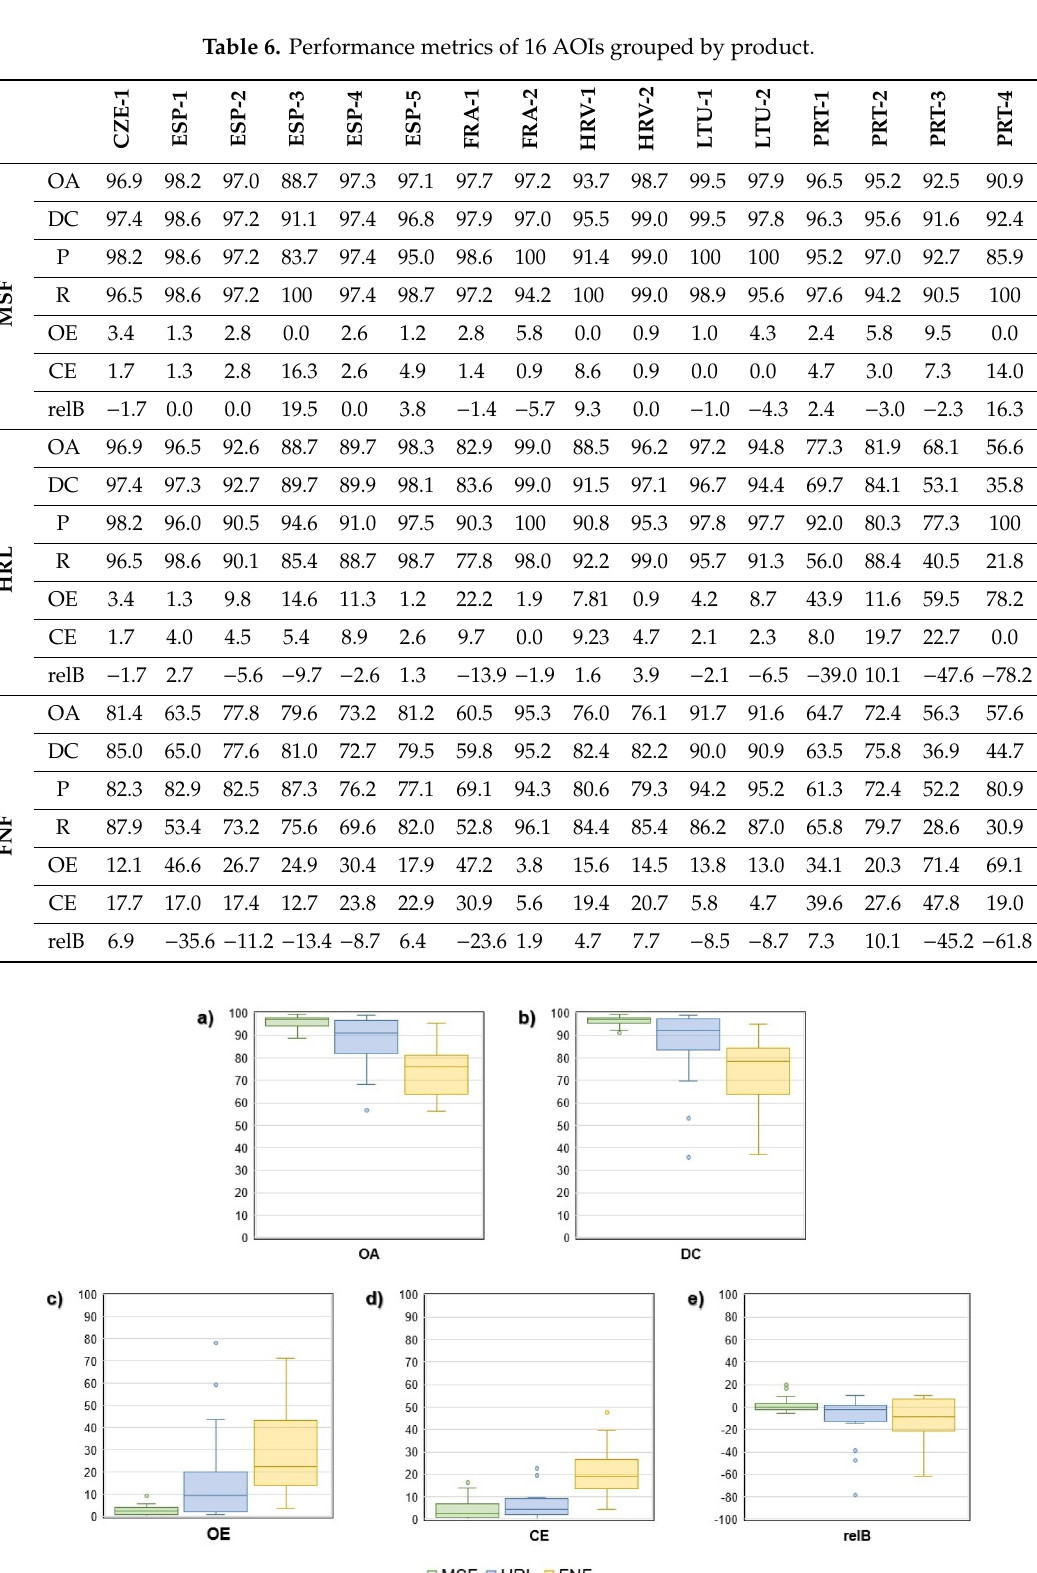
Table 6. Performance metrics of 16 AOIs grouped by product. C Z E - 1